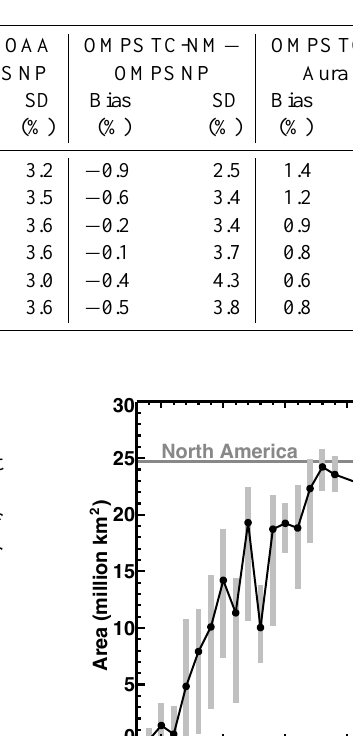
Table 2. Summary of total ozone comparisons poleward of 55 ◦ S and for September–November 2012.